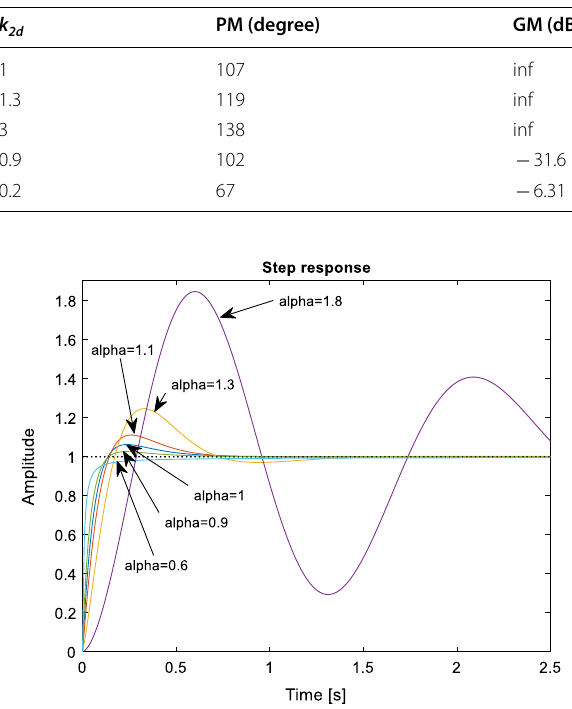
Fig. 39 Step response of the RSC control circuit using FFOADRC (for k 2d 1.1, ω c 10, k 1d 1, and different α) = = =